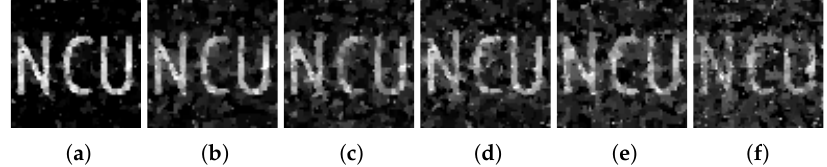
Figure 10. When the sampling rate is 0.1, the image reconstructed from the original image measured by Gaussian random matrix added with a mean of 0 and variance of ( a ) 0, ( b ) 0.02, ( c ) 0.04, ( d ) 0.06, ( e ) 0.08, and ( f ) 0.1. The reconstructed algorithm is TVAL3. The resolution of the image is 64 × 64 for all.